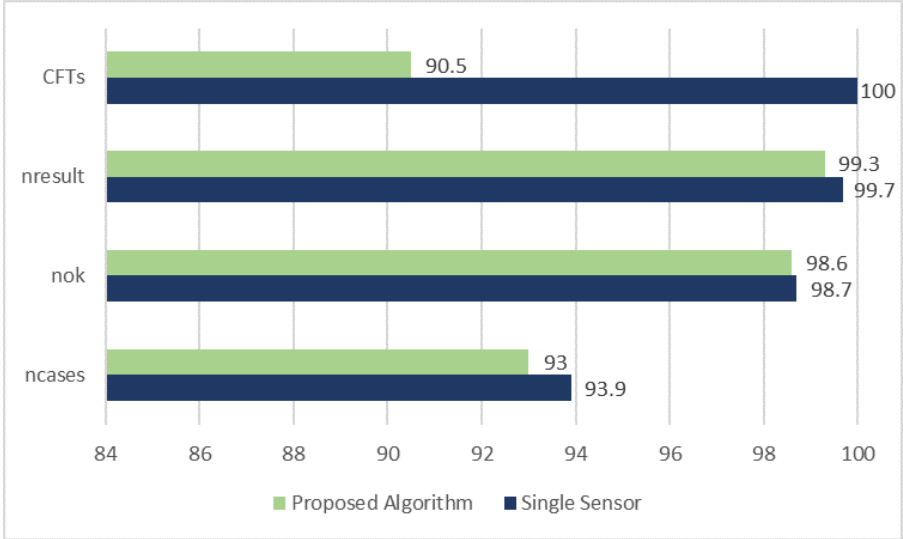
Figure 5. Comparison of accumulated CFTs and Statistics Percentage (for same CFTs at P D =